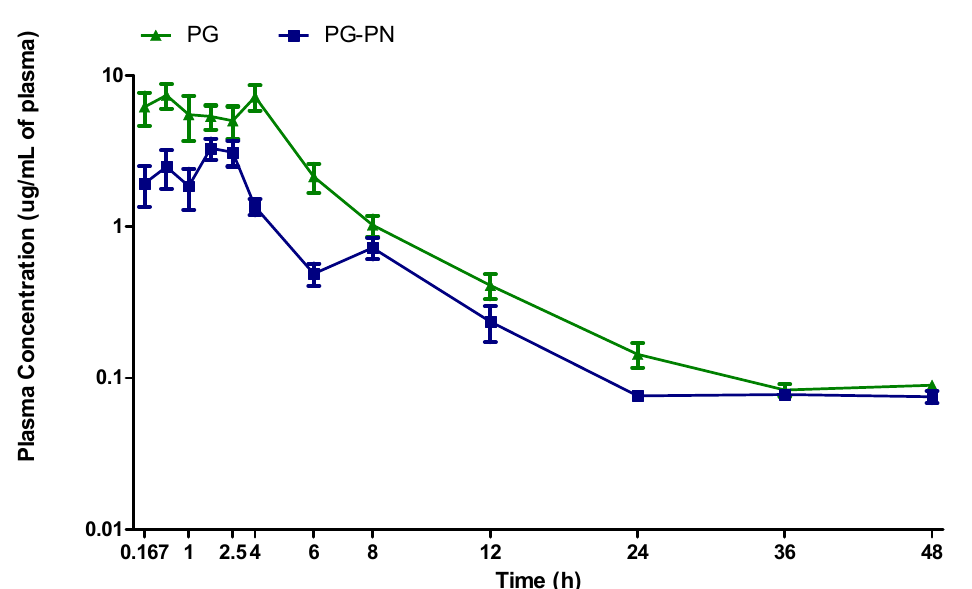
Figure 10. Mean pharmacokinetic profile after oral administration of PG and PG-PN (10 mg/kg) in rats (n = 6, for each profile) administered as a single dose.